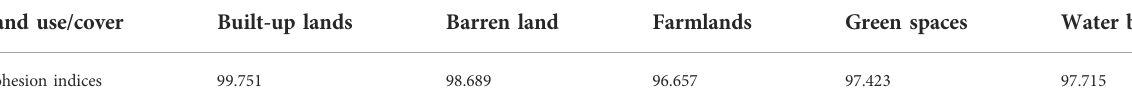
TABLE 4 COHESION scores for all fi ve land uses in city of Tabriz.